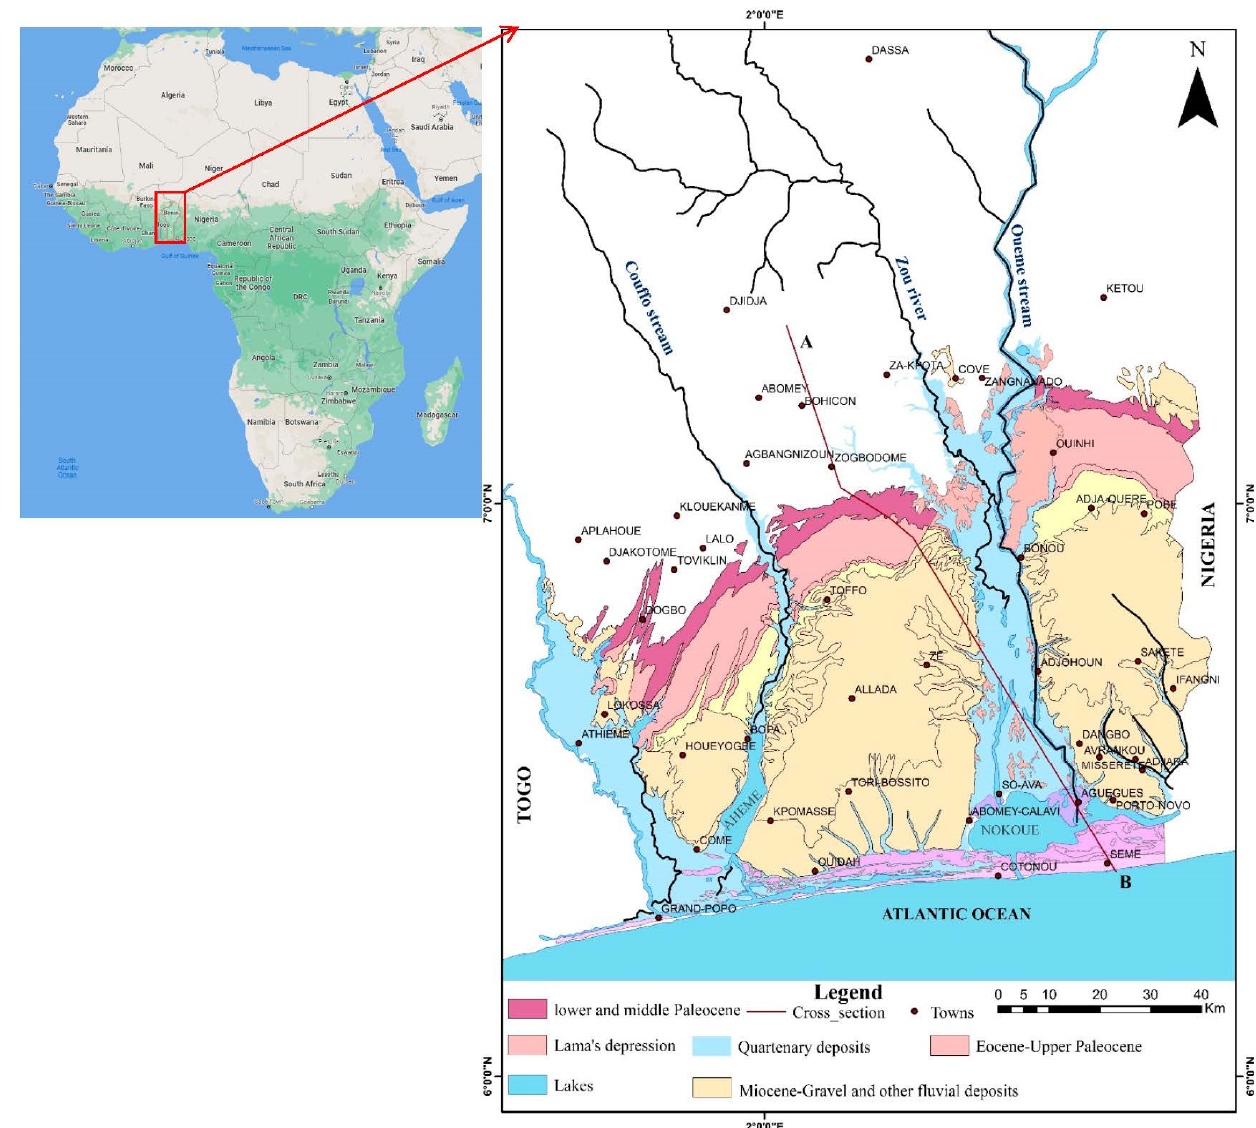
Figure 1. Geographic location and geological formations of the coastal zone of